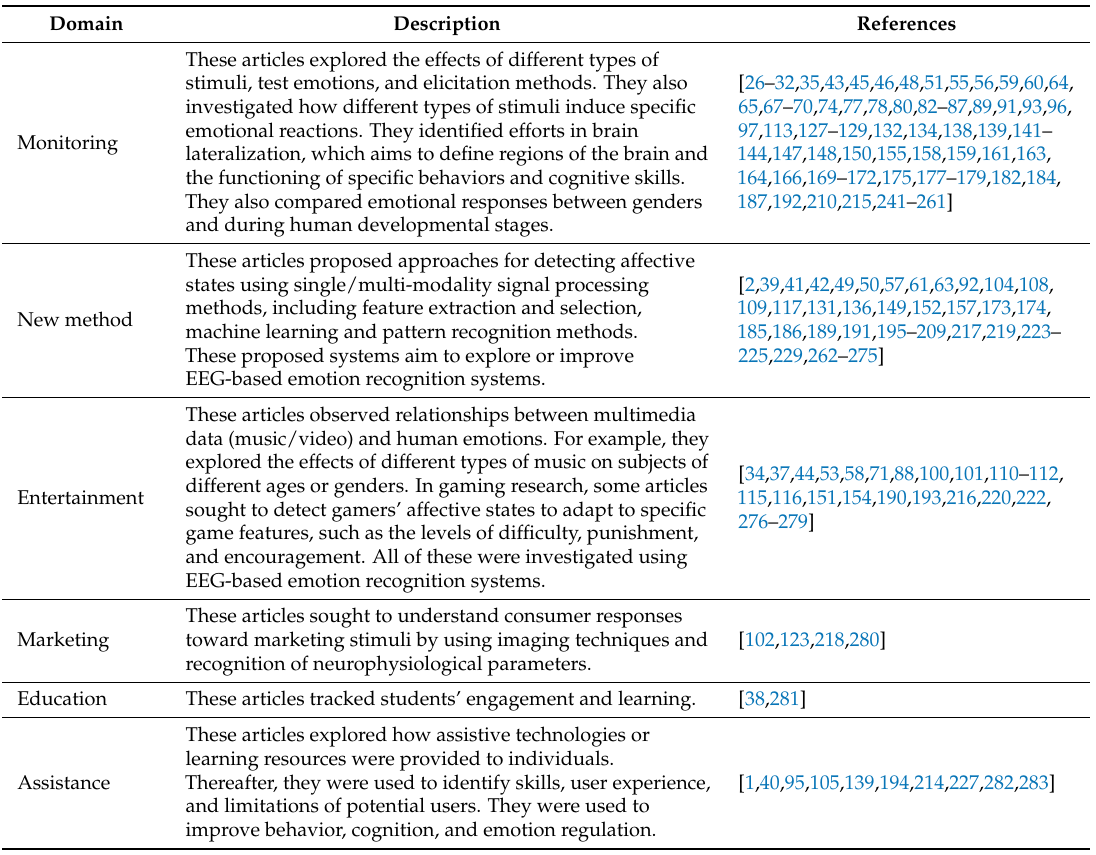
Table 7. Non-medical application